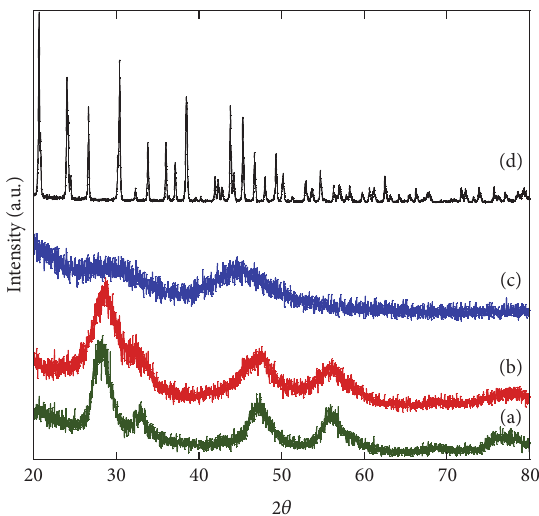
Figure 1: XRD patterns of the as-synthesized powders: N-SDC20 (a), T-SDC20 (b), C-SDC20 (c), and U-SDC20 (d).